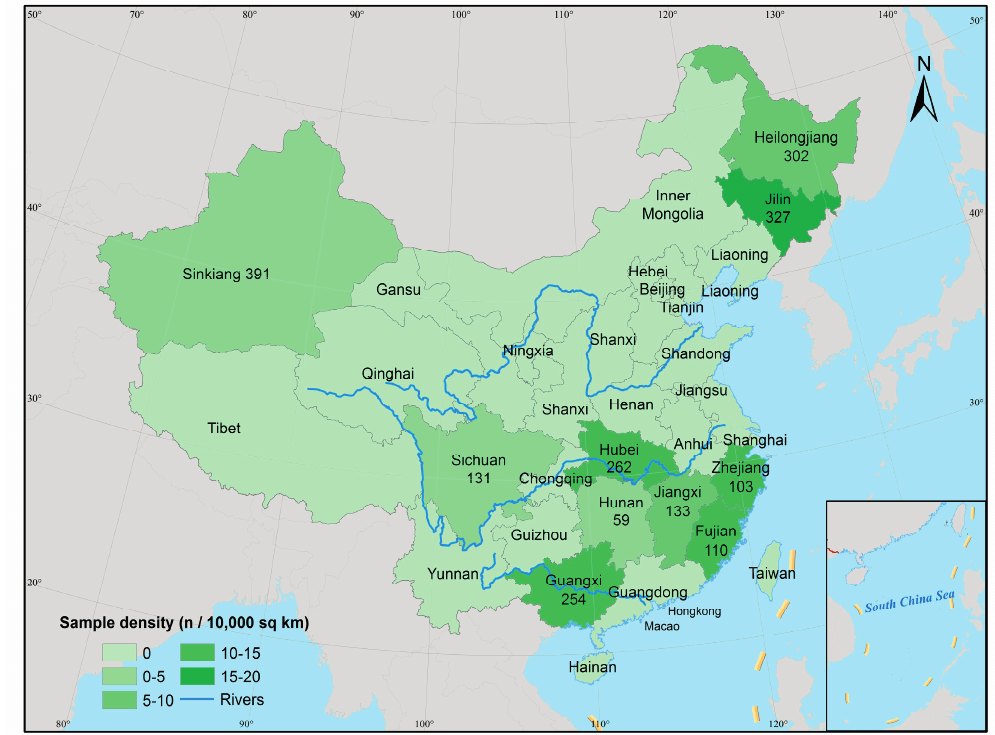
Figure 1. Sampling density of the Chinese Soil Spectral Library in China by province. Map labels show the total number of samples per province in